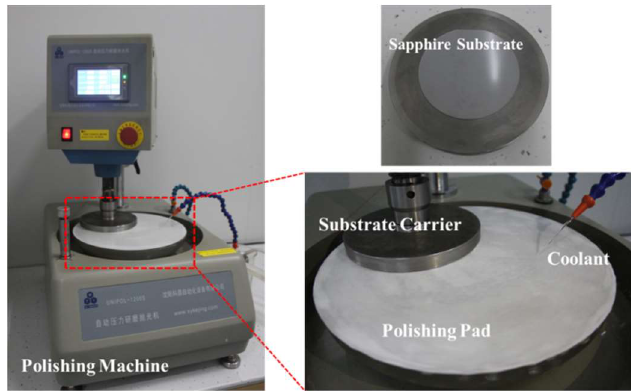
Figure 6. Schematic diagram of the rotary-type polishing experimental setup.